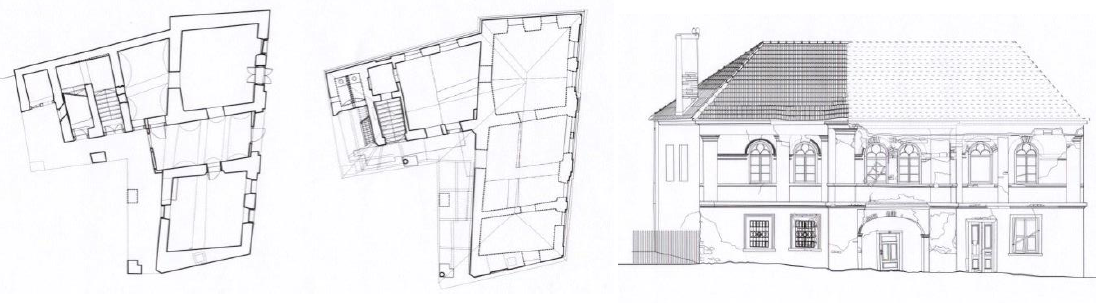
Figure 6: Reformed Parsonage plan views Figure 7: Main façade ground floor (left), first floor (right) Source: Apostol & Bâlici, 2010, plate no. 42 Source: Apostol & Bâlici, 2010, plate no.